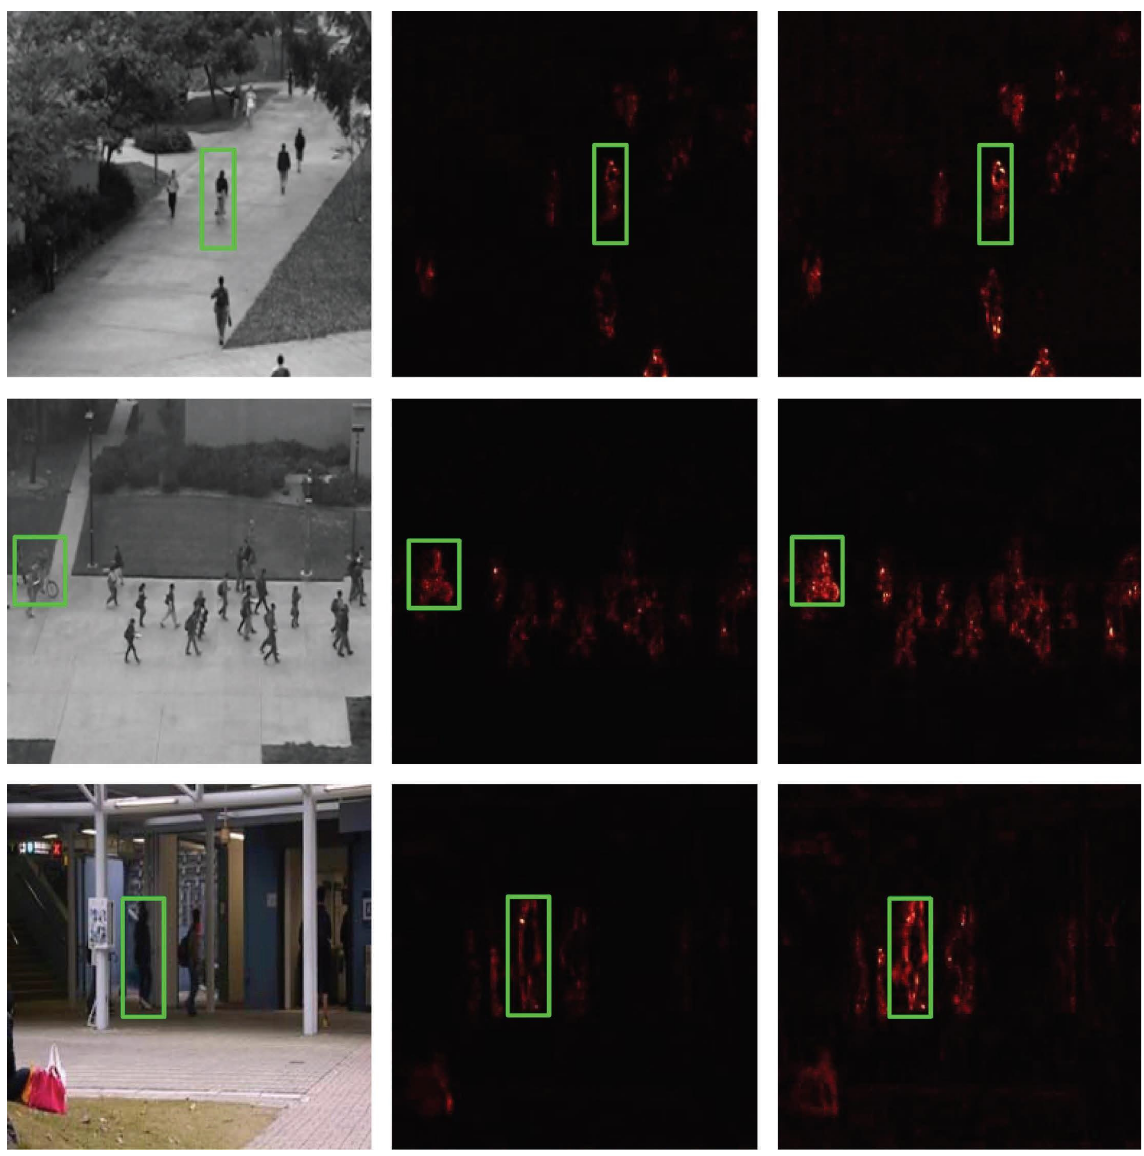
Figure 11: Refactoring error of abnormal behavior